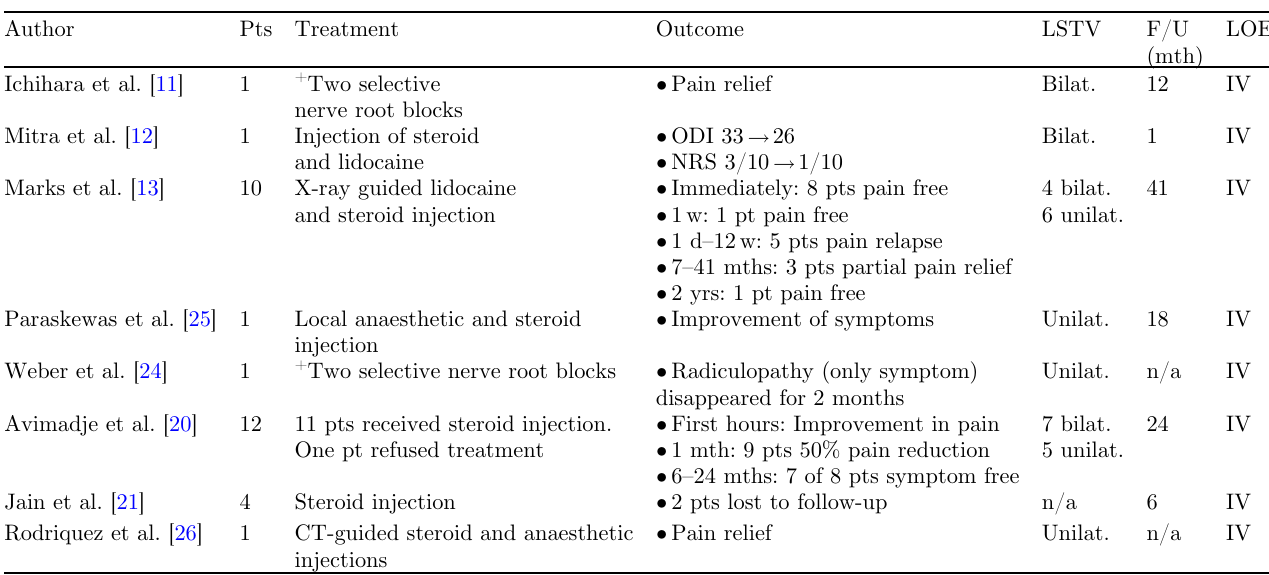
Table 2. Steroid injection.